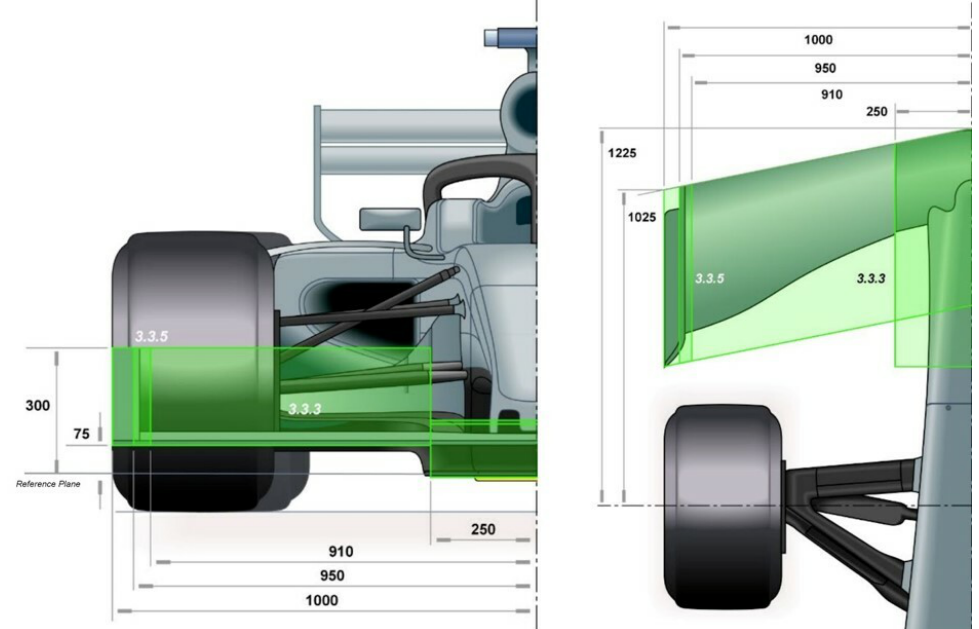
Figure A1. 2021 Regulations. Image extracted from the FIA regulations (Article 3.3 front wing [81]). The green areas are the size limits set by the FIA regulations. The non-dimensional numbers on the green areas stand for the subsection of Article 3.3 from the FIA regulations, in which additional information can be